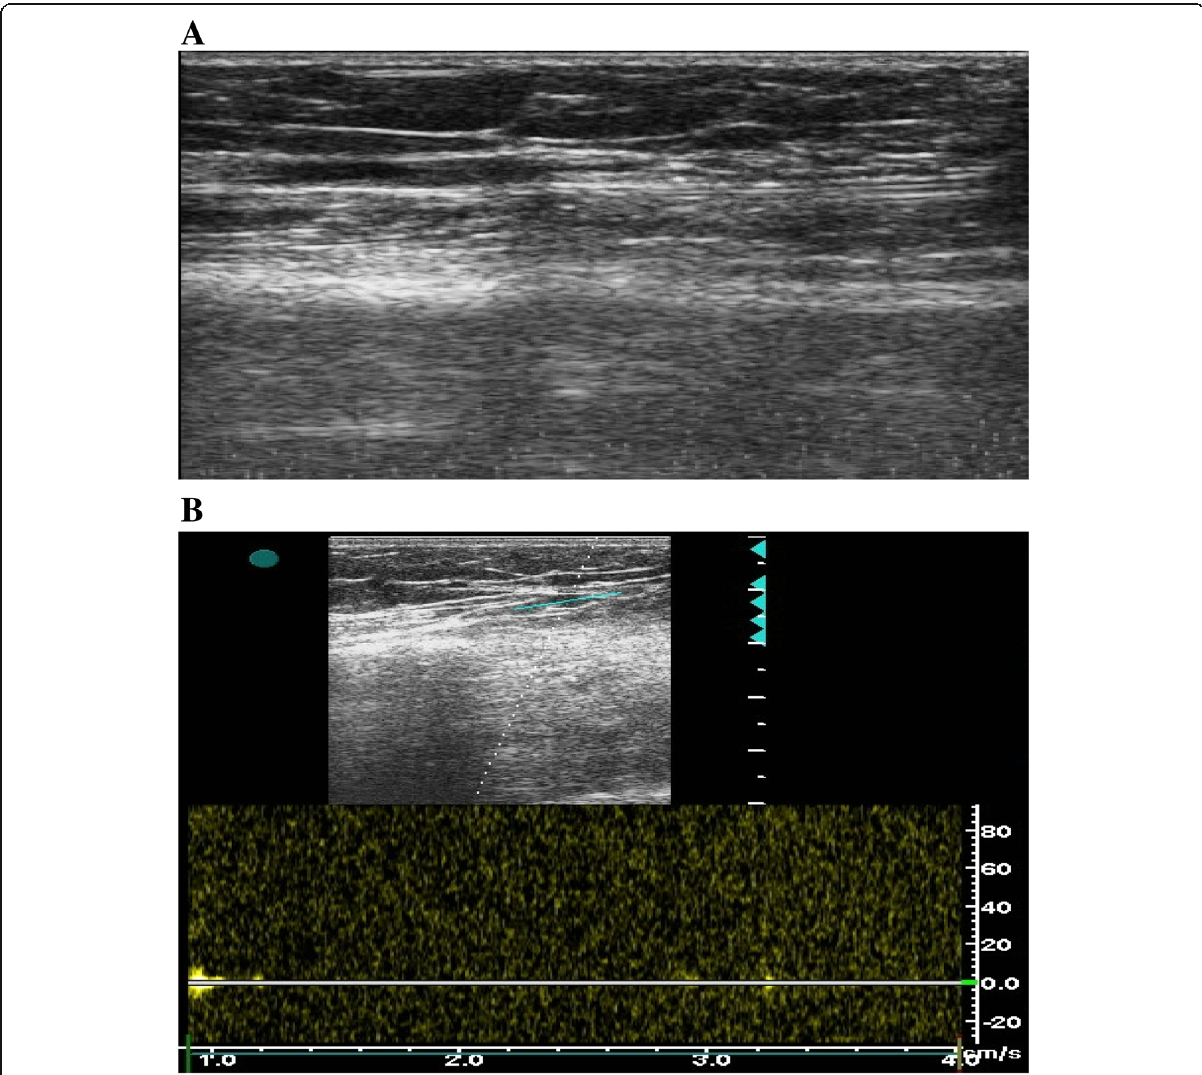
Fig. 3 Duplex ultrasonography of an occluded RA after TR coronary catheterization. a B-mode showing total occlusion of the RA with thrombosis distal to the site of occlusion. b Spectral analysis showing no flow distal to the site of